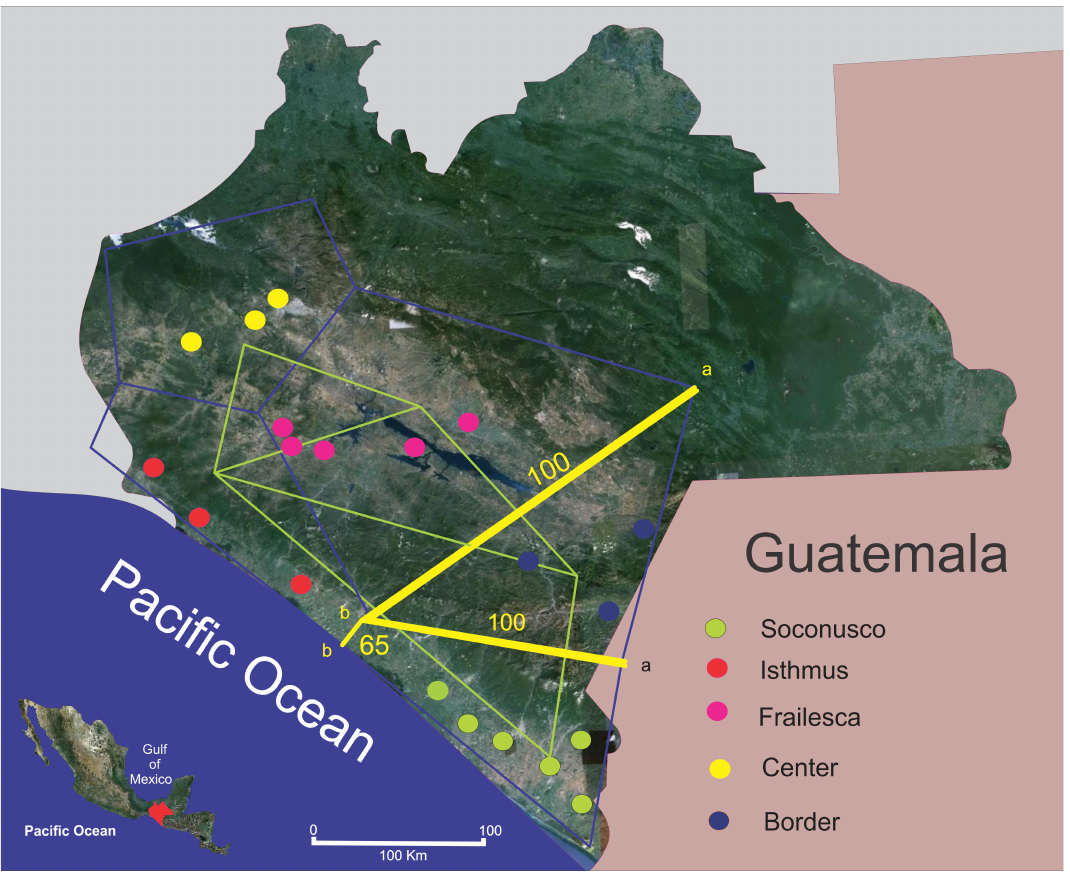
Figure 4. Map of five populations of Chiapas showing the two main genetic barriers ( a and b yellow lines) found by the Monmonier algorithm (Barrier © version 2.2), based on Fst distances. Thickness and the number on the side of the barriers indicate the percentage